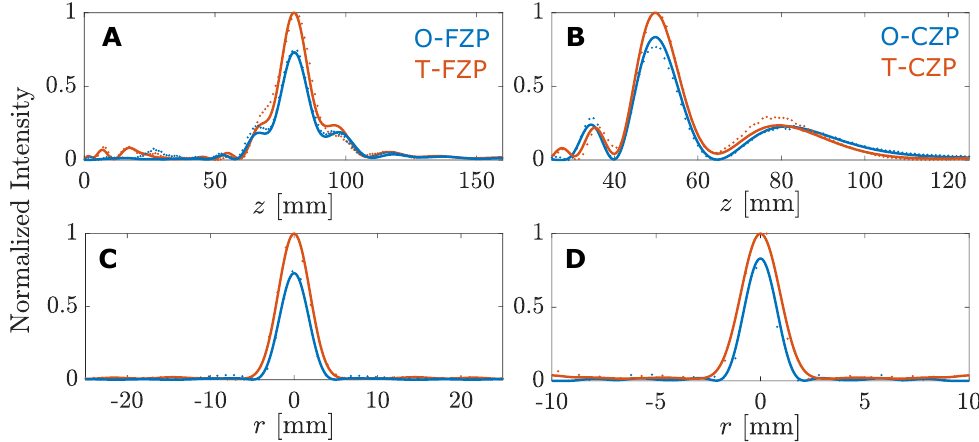
Figure 5. ( A , B ) Longitudinal and ( C , D ) lateral intensity cuts from the maps depicted in Figure 4. ( A , C ) correspond to the FZP case, while ( B , D ) correspond to the CZP lens. Simulation and experi- mental results are depicted with solid and dotted lines,